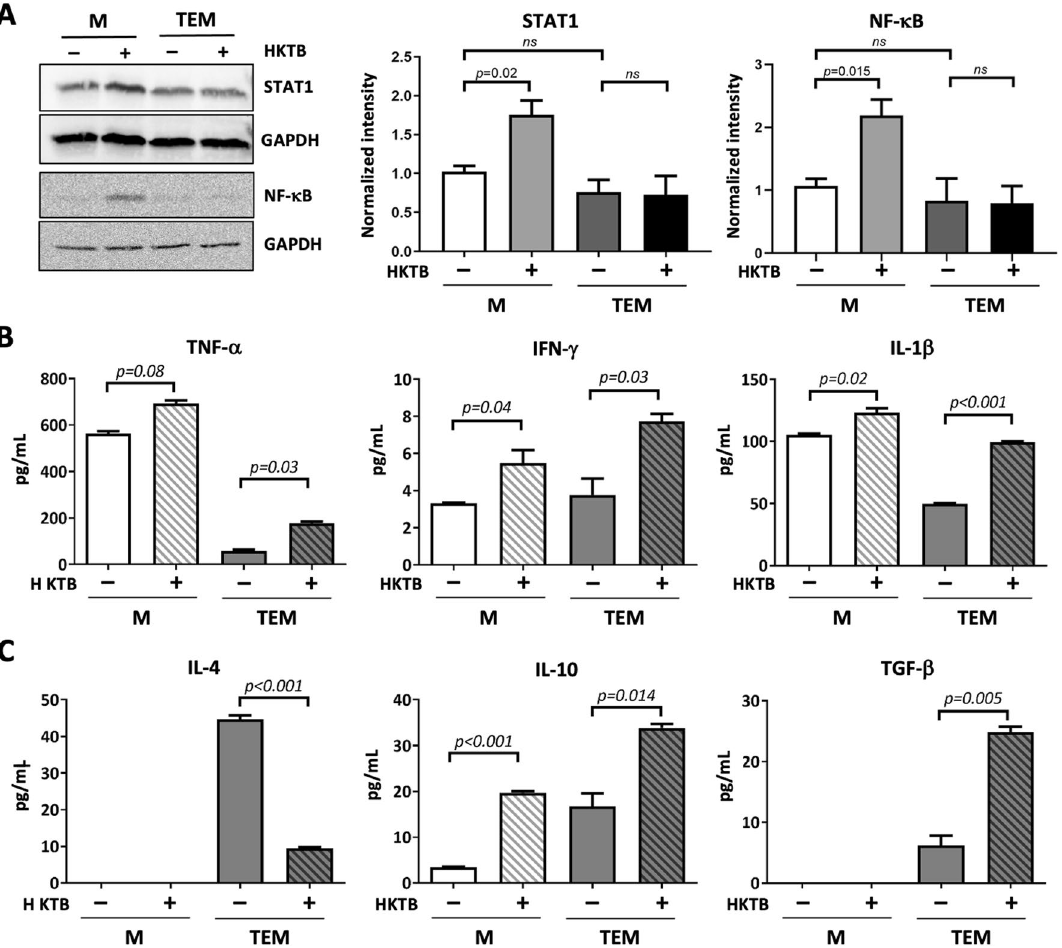
Figure 4. Functional validation. ( A ) Representative Western blot images and statistical results for expression levels of signal transduction and activator of transcription 1 (STAT1) and nuclear factor (NF)-κB in heat-killed tuberculosis (HKTB)-stimulated classically activated macrophages (Ms) and tumor-educated macrophages (TEMs) before and after HKTB stimulation. GAPDH was used as an internal control. Measurement of levels of ( B ) proinflammatory cytokines and ( C ) anti-inflammatory cytokines released by Ms and TEMs before and after HKTB stimulation. Statistical analyses were performed by Student’s t -test. ns, not